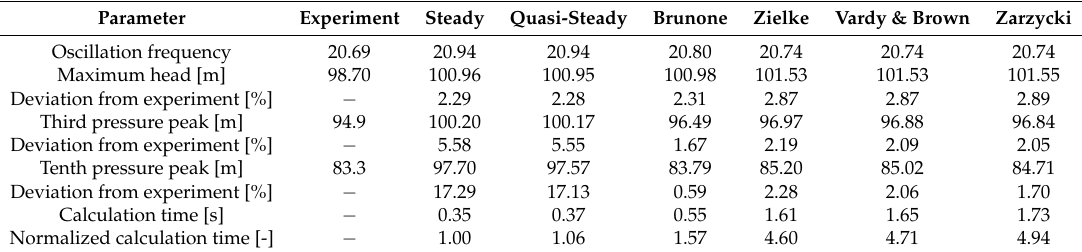
Figure 7. Comparison of the experimental data (experiment 3 [41]) with the simulated results for each friction model. Note that the steady and quasi-steady friction models gave similar results and all the CB friction models also gave similar results. Table 4. Comparison of model and experimental results for experiment 3